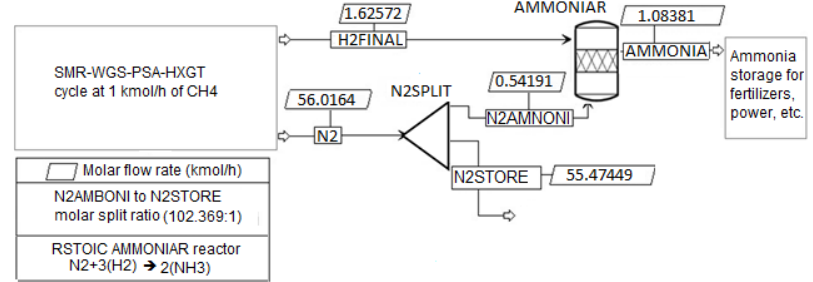
Figure 16. Ammonia production (Second mode).